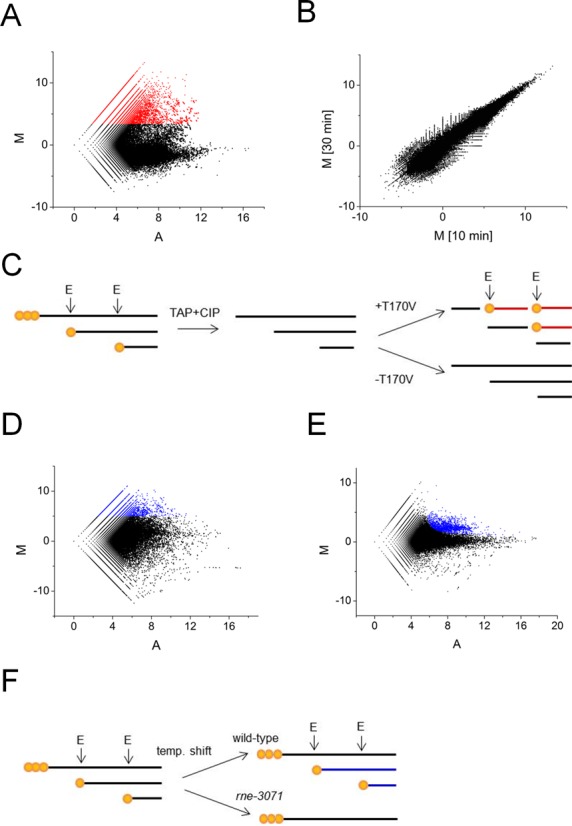
Scatterplot analyses of RNA-seq data. (A) shows a plot of M (ratio) and A (intensity) values corresponding to the reads obtained after and before incubation of 5′-hydroxylated RNA with T170V for 10 min. Each point corresponds to a unique 5′ end. The points coloured red have M-values ≥3.4. (B) is a plot of M-values obtained for panel A against M-values corresponding to reads obtained for the same reaction but after and before incubation for 30 min. (C) shows a schematic illustration of fragments generated in (A) with increased values of M. Primary transcripts, depicted with 5′-triphosphorylated ends (three orange circles) and the downstream products of cleavage, depicted with 5′-monophosphroylated ends (single orange circle), were isolated within total RNA isolated from Escherichia coli. Following mRNA enrichment, the RNA was treated with TAP and CIP so that all the ends were 5′ hydroxylated. Sites of direct entry in vitro were identified by sequencing the downstream products of cleavage (red fragments). The 5′-monophosphorylated ends of these fragments facilitated their cloning. For (A) and (B) enzyme monomer and enriched RNA from BW25113 concentrations were 300 nM and 30 ng/μl, respectively. (D) is a plot of M and A-values corresponding to reads obtained for an rne-3071 strain and its congenic WT partner at 44°C, a non-permissive temperature. The points coloured blue have M-values ≥5. (E) as (D) except the values correspond to reads obtained for an rng disrupted strain and its WT partner. The points coloured blue correspond to candidate sites of RNase G cleavage in vivo. (F) shows a schematic illustration of fragments generated in (D) with increased values of M. Prior to the temperature shift, RNase E cleaves primary transcripts as part of their processing and degradation. This continues in the WT, but not the rne-3071 strain at a non-permissive temperature. As a result, products of RNase E cleavage (blue fragments) can become depleted in the rne-3071 strain.